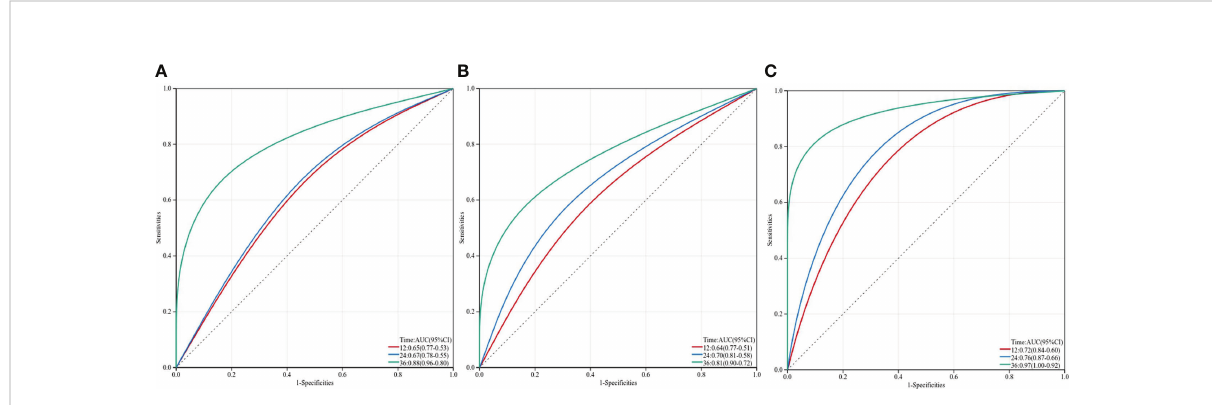
FIGURE 5 Three-year time-dependent ROC curves for overall survival of in fl ammation-immunity-nutrition score, AFP and IINS-AFP classi fi cation. IINS, in fl ammation-immunity-nutrition score; AFP,